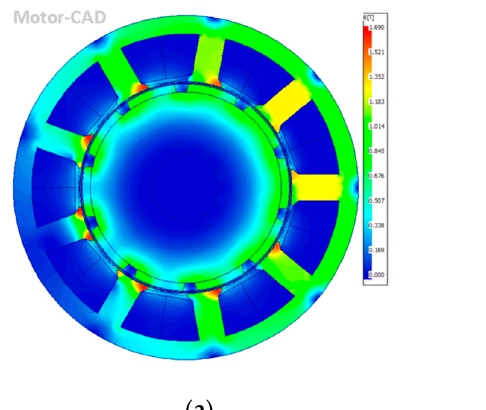
Figure 4. Magnetic force distribution of the for a machine with Q = 9, p = 10.